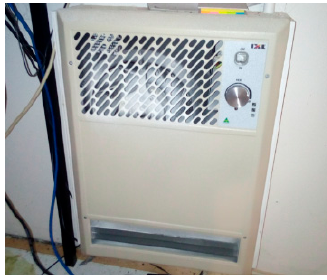
Figure 10. Wall-mounted heater.